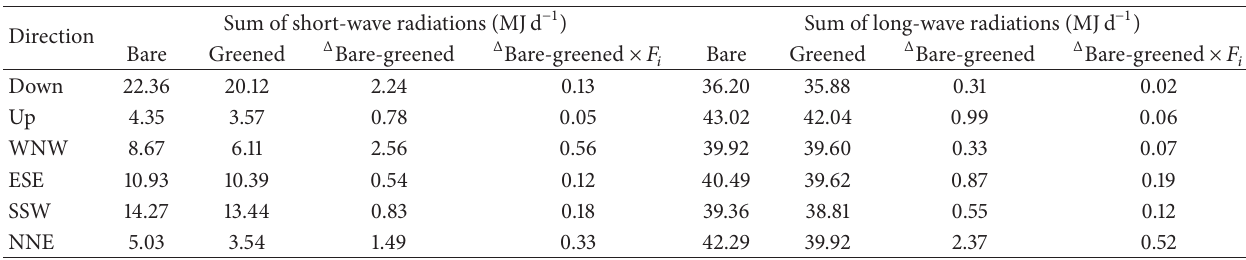
Table 4: Sum (00–23 CET) of long- and short-wave radiation at the greened and the bare site up- and downward (up, down) and from the cardinal points (west-northwest (WNW), east-southeast (ESE), south-southwest (SSW), and north-northwest (NNE) (direction from the fac¸ades)) on 7, 23, 2013. 𝐹 𝑖 is the angular factor used in calculation of mean radiant temperature (0.06 for up- and downward radiation and 0.22 for radiation from the cardinal points).